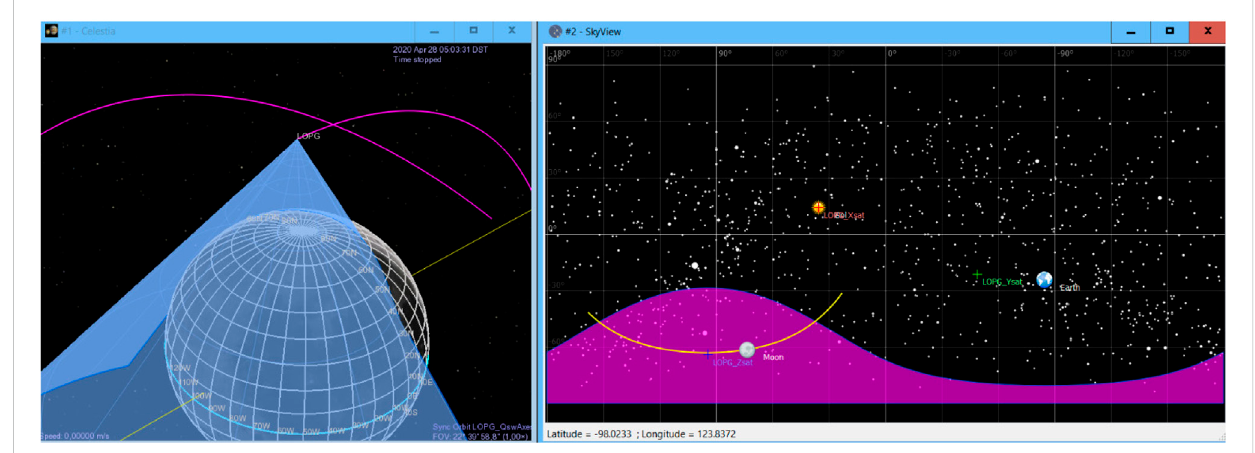
FIGURE 24 cGCRD FOV. Left: cGCRD FOV near periapsis (light blue cone), dominated by the albedo GCR particles from the Moon (grid sphere). Right: projection on the sky of the cGCRD FOV along the Gateway orbit (in